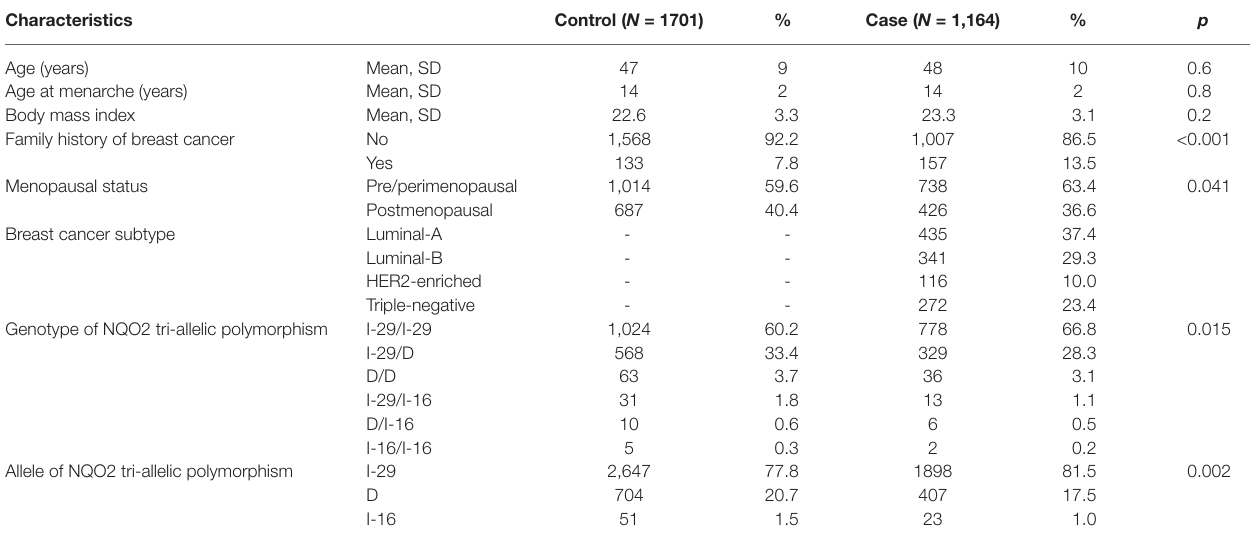
TABLE 1 | Basic information of the breast cancer cases and the healthy controls.